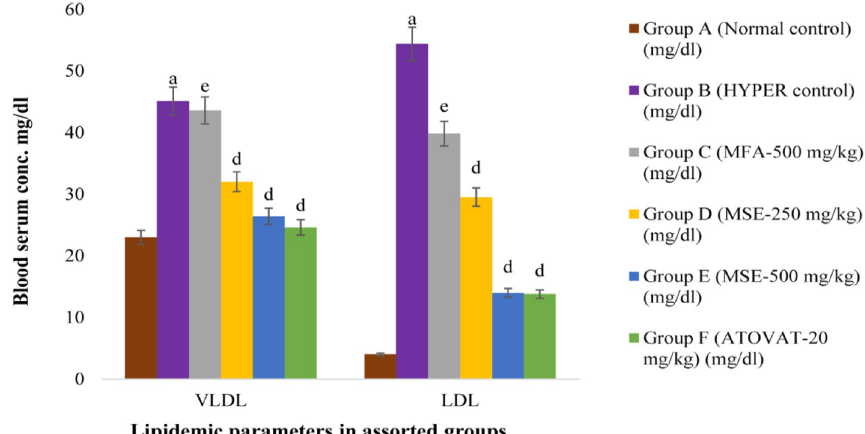
Fig. 6 Comparative expression of VLDL and LDL of MM extracts at different conc. in HCD mice. The expression of these markers are mean standard error of mean (SEM); where n ±